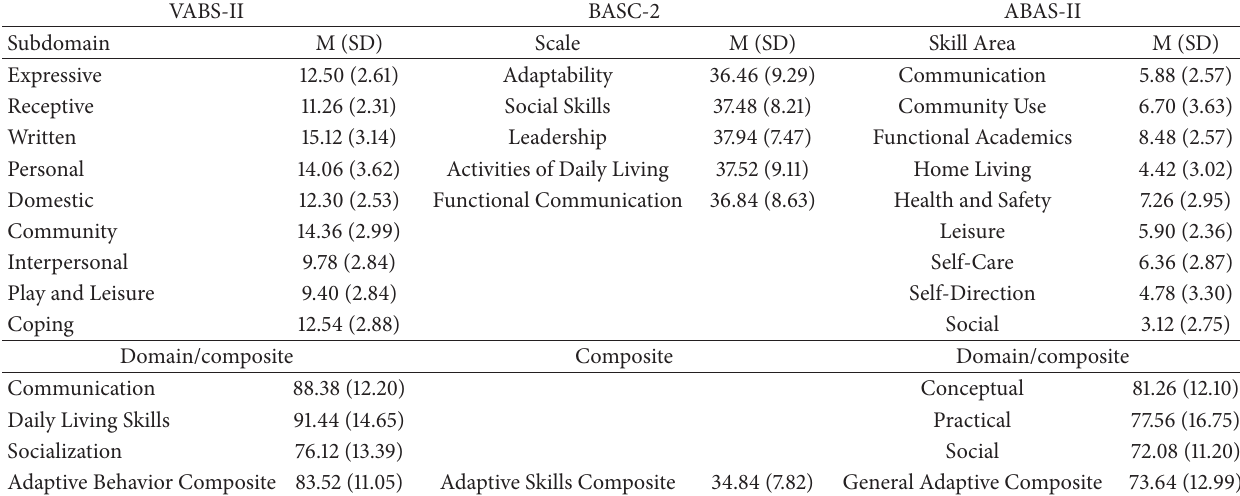
Table 2: Means and standard deviations in the original metrics for the VABS-II, BASC-2 PRS, and